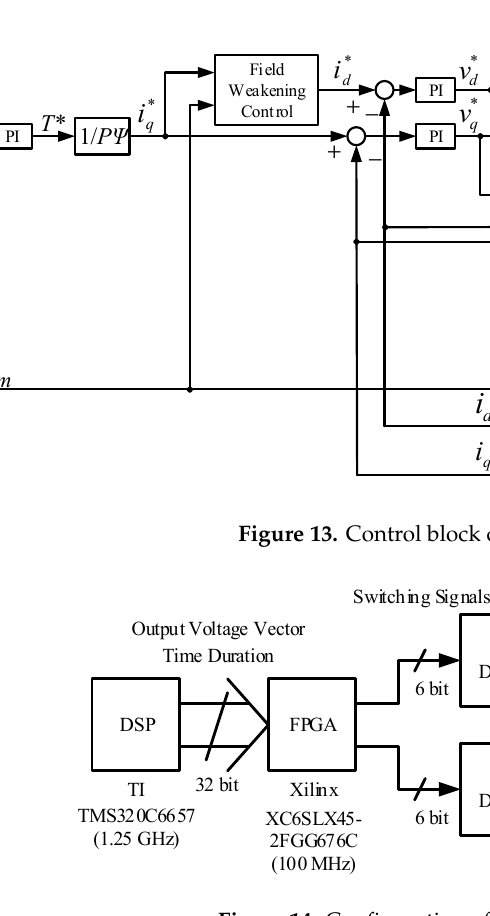
Figure 14. Configuration of controller.